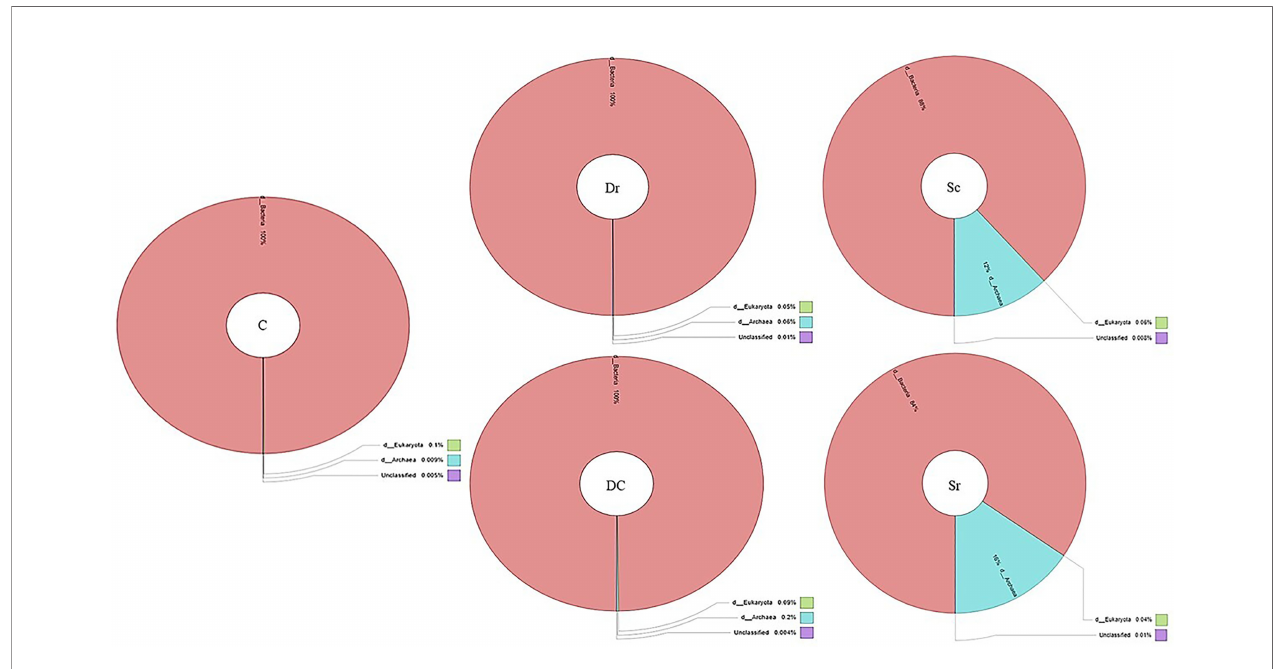
FIGURE 2 | Krona chart of domains detected in soil samples (C, Dc, Dr, Sc, and